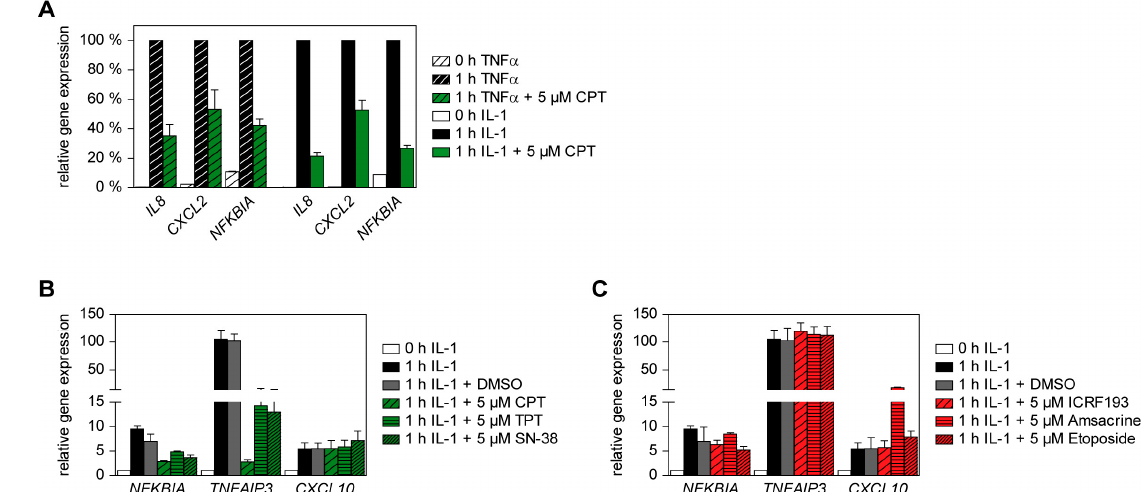
Figure 4. Effect of TOP1 inhibitors on IL-1-induced inflammatory gene expression in KB cells. ( A ) KB cells were pre-treated for 2 h with CPT and then stimulated for 1 h either with TNF α (20 ng/mL) or with IL-1 (10 ng/mL). Cells were harvested and analyzed by RT-qPCR for expression of IL8 , CXCL2 and NFKBIA as shown. To facilitate comparison, maximal gene expression for the respective genes was set as 100%, error bars display SEMs obtained from three independent experiments performed in duplicate. ( B , C ) KB cells were pre-treated for 2 h with 5 µ M of various TOP1 ( B ) or TOP2 ( C )-inhibitors as shown, followed by the addition of IL-1 (10 ng / mL) for 1 h. Expression of various indicated inflammatory NF- κ B target genes was assessed via RT-qPCR. Error bars show SEMs obtained from three independent experiments performed in duplicate.